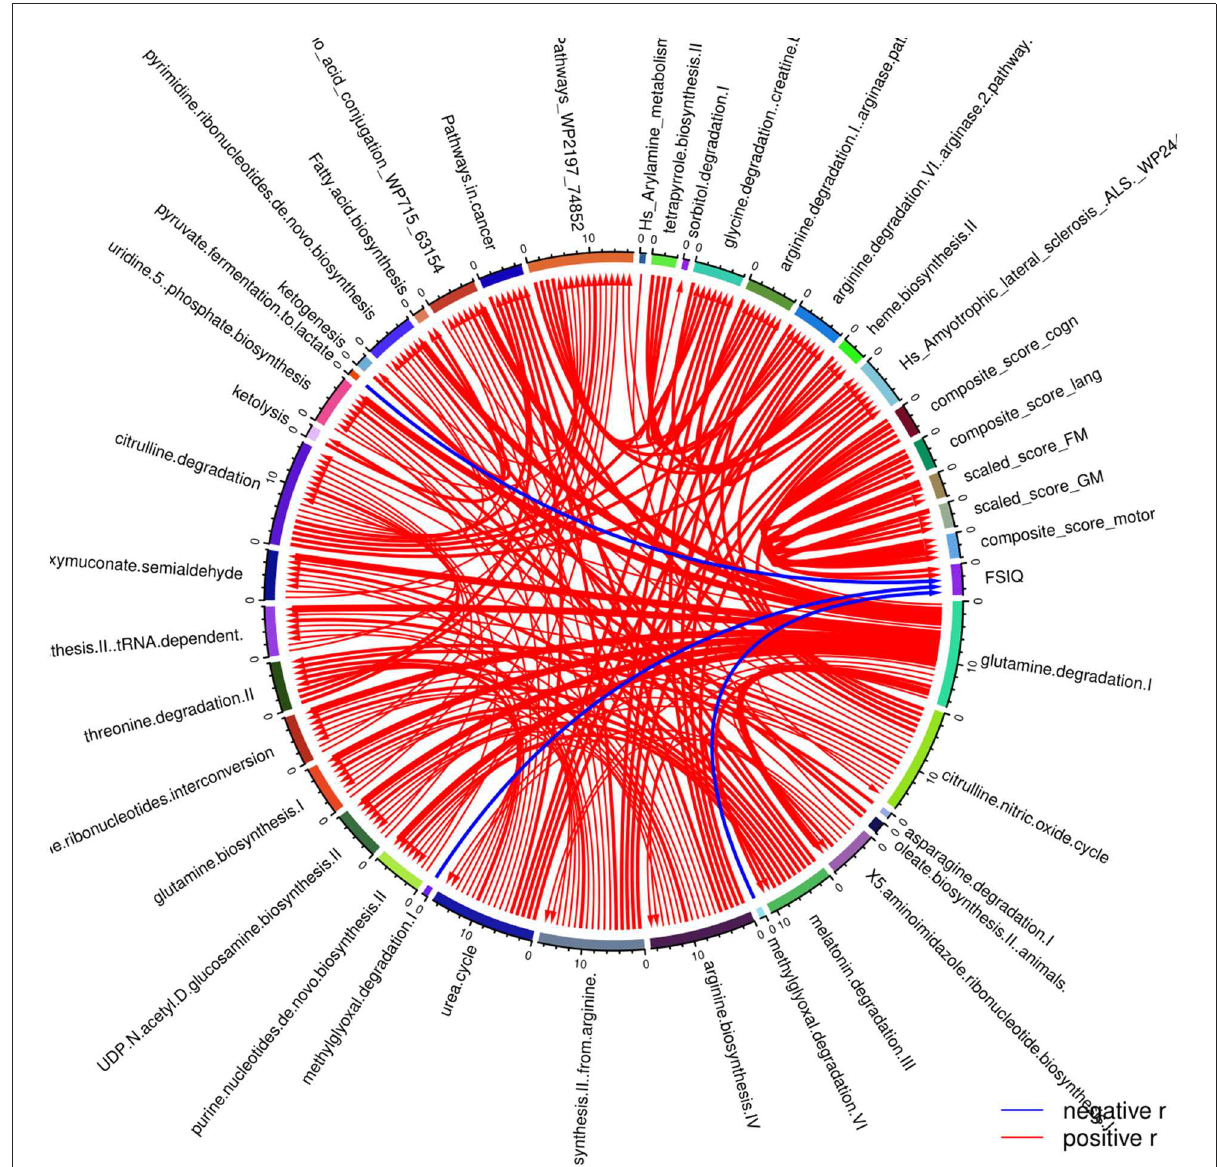
FIGURE5 Correlation globe of the health outcomes regarding the neurodevelopment of the children participated in the PHIME cohort and the metabolic pathways. Cognitive capacity of the children (FSIQ) is negatively associated the following metabolic pathways: methylglyoxal degradation I, the methylglyoxal degradation VI and the pyruvate fermentation to lactate. In addition, motor development is significantly negatively associated with the urea cycle, the biosynthesis of arginine, the biosynthesis of proline from arginine, the degradation of citrulline and the citrulline nitric oxide cycle.